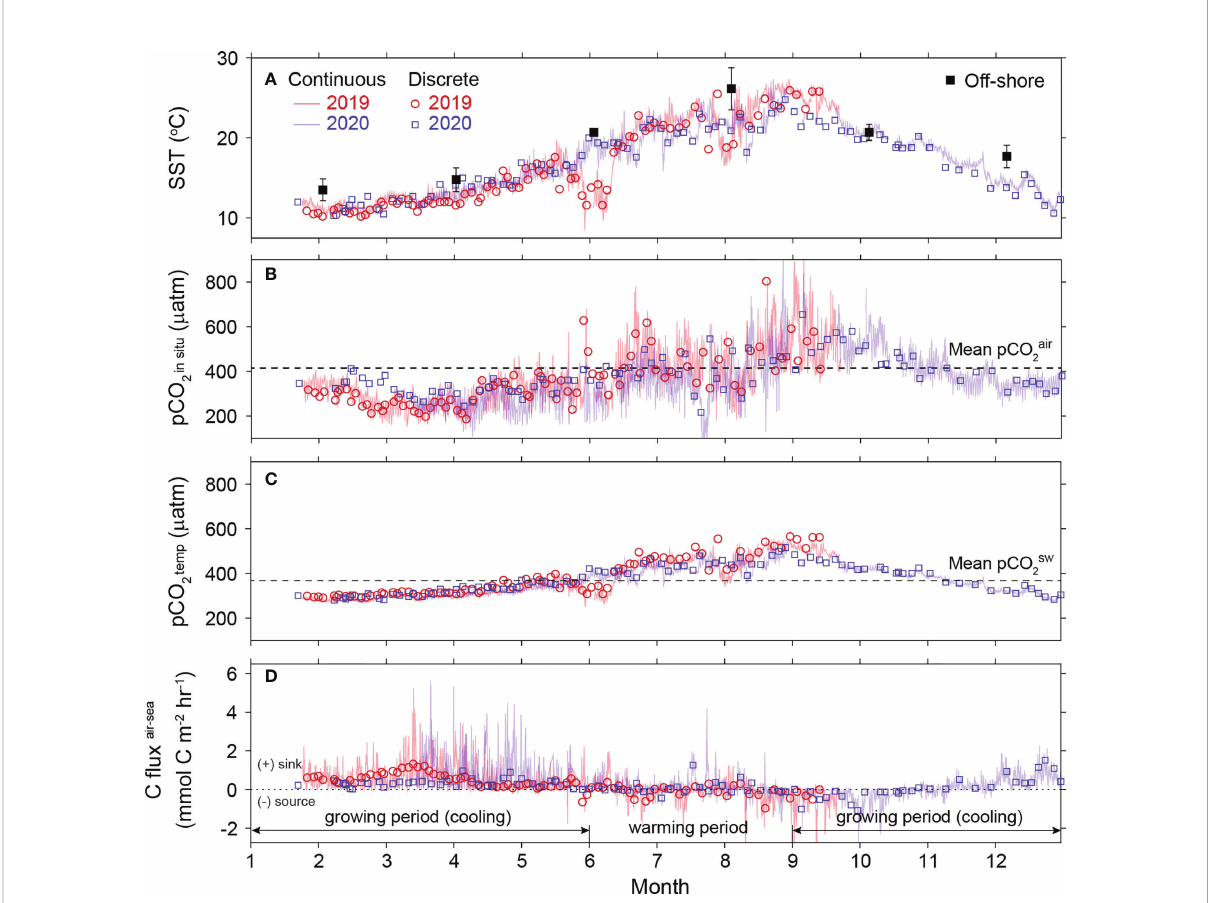
FIGURE 2 Temporal changes in (A) sea surface temperature (SST), (B) seawater pCO 2 , (C) seawater pCO 2 arising from SST change only, and (D) air-sea C fl ux for the period 2019 − 2020. Lines and open symbols indicate the continuous and discrete data, respectively, obtained in 2019 (red) and 2020 (blue). Solid symbols (black) in (A) represent the seasonal changes in off-shore SST. Horizontal line in (B, C) show the level of mean pCO 2 of the air (415 μatm) and seawater (367 μatm),